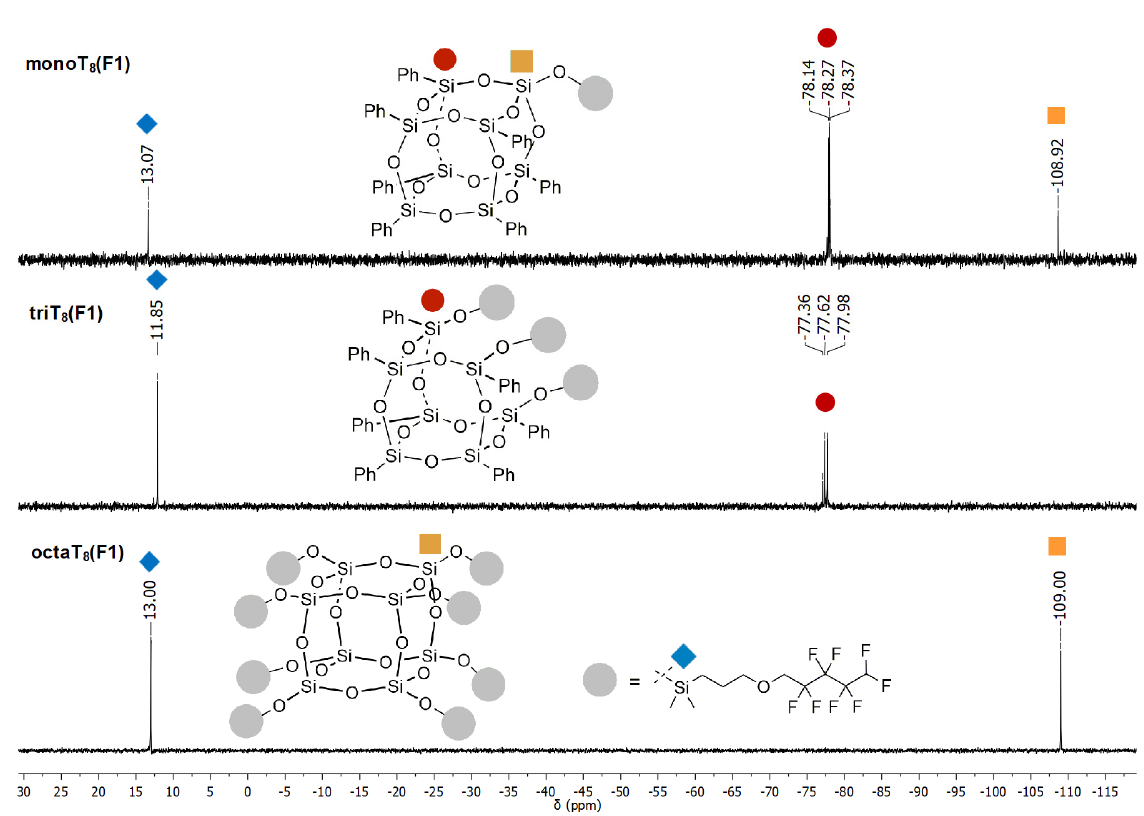
Figure 2. Selected range of stacked 29 Si NMR spectra of monoT 8 (F1) , triT 8 (F1) and octaT 8 (F1).